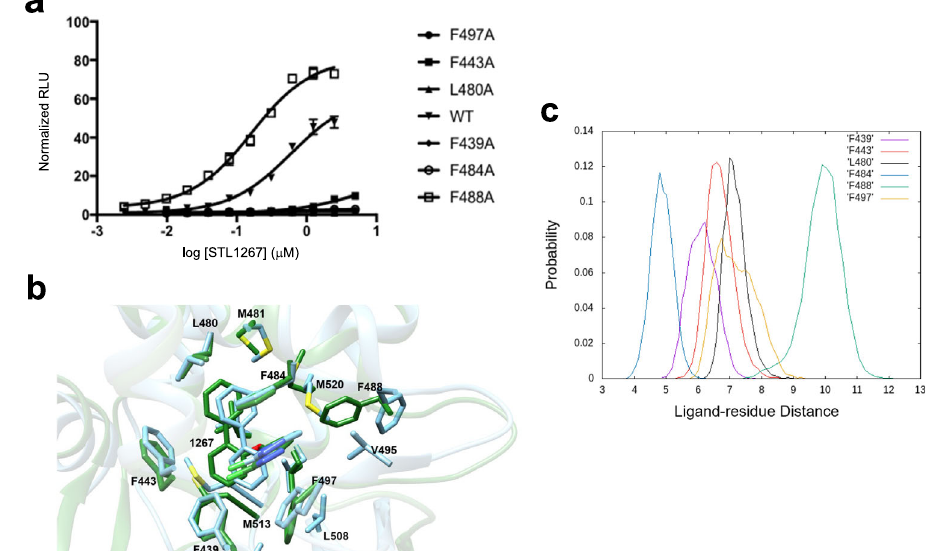
Fig. 6 | Mutational analysis of amino acid residues within the ligand binding typically repeated three times. Data arepresented asmean±SEM. b Overlayof the pocket ofREV-ERB α . a Resultsof a two-hybrid reporter assay(Gal4-FL REV-ERB α / ligand binding pockets of REV-ERB α /STL1267/NCoR ID1 complex before (green) andafter(blue)theMDsimulations. c DistanceprobabilitydistributionforSTL1267 NCoR1-VP16) assay illustrating the effects of mutation of amino acid residues that ▾ and selected amino acid residues (F497A yellow, F443A red, L480A black, F439A interactwithSTL1267withintheligandbindingpocket.(WT ,F497A ● ,F443A ■ , ♦ , F484A ○ , F488A □ ). Each point in the biochemical and cell- purple, F484A blue, F488A L480A ▲ , F439A based experiments represent triplicate determinations and experiments were